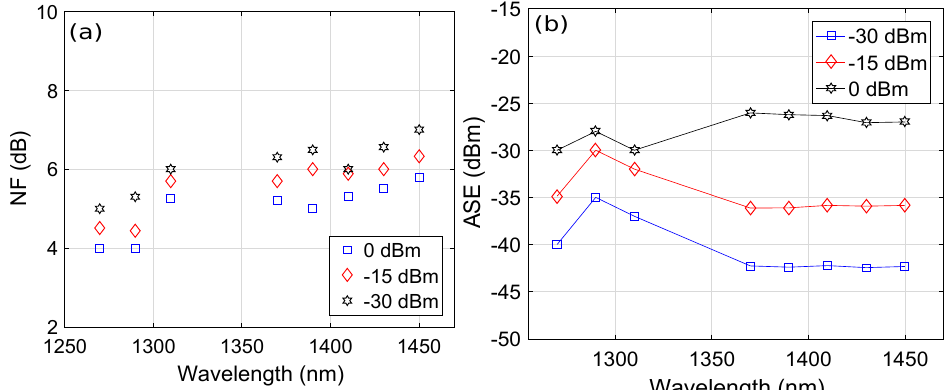
Figure 6. Wavelength versus ( a ) NF plots as a function of signal power and ( b ) ASE plots as a function of signal power.